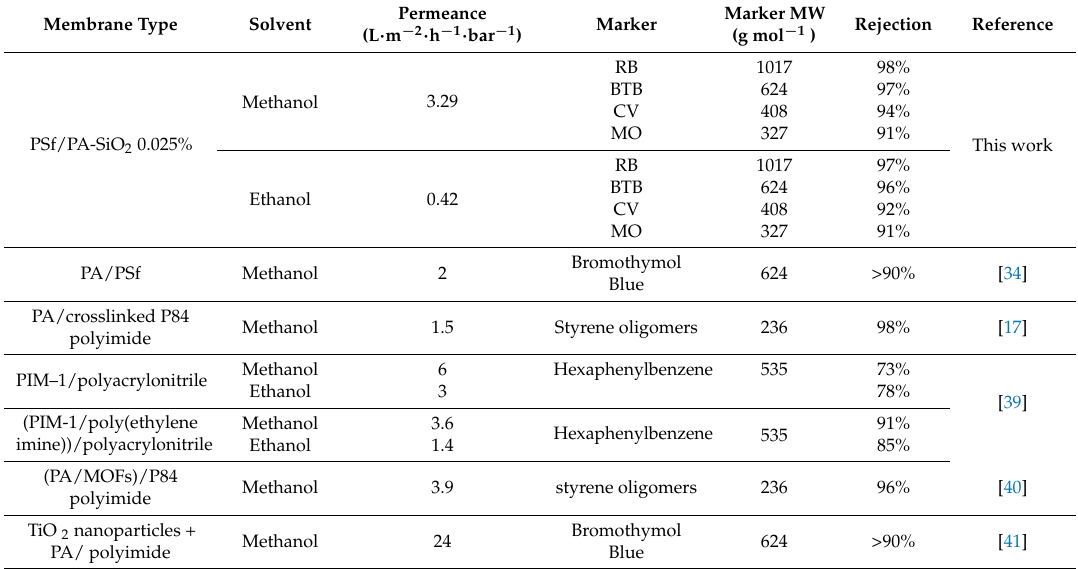
Table 3. Performance comparison of PSf/PA-SiO 2 0.025% membrane with the other TFC membranes reported in the